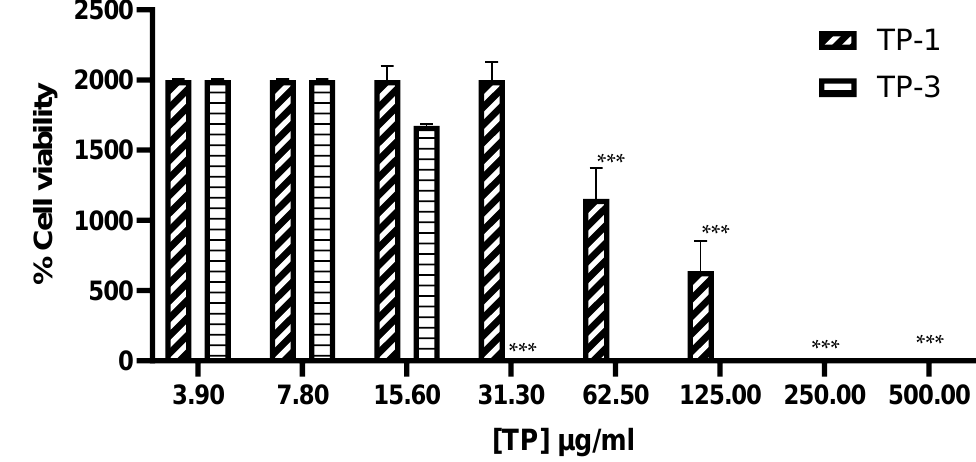
Figure 1. CFU count and MIC of TP-1 and TP-3 on S . mutans . p ≤ 0.05 was considered as statistically significant, *** p ≤